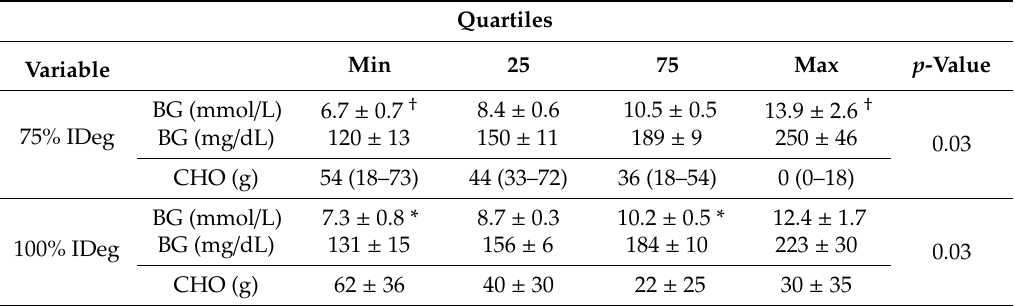
Table3. Pre-exercisebloodglucosequartilesbasedonmedian,25thand75thpercentilewithconcomitant carbohydrate